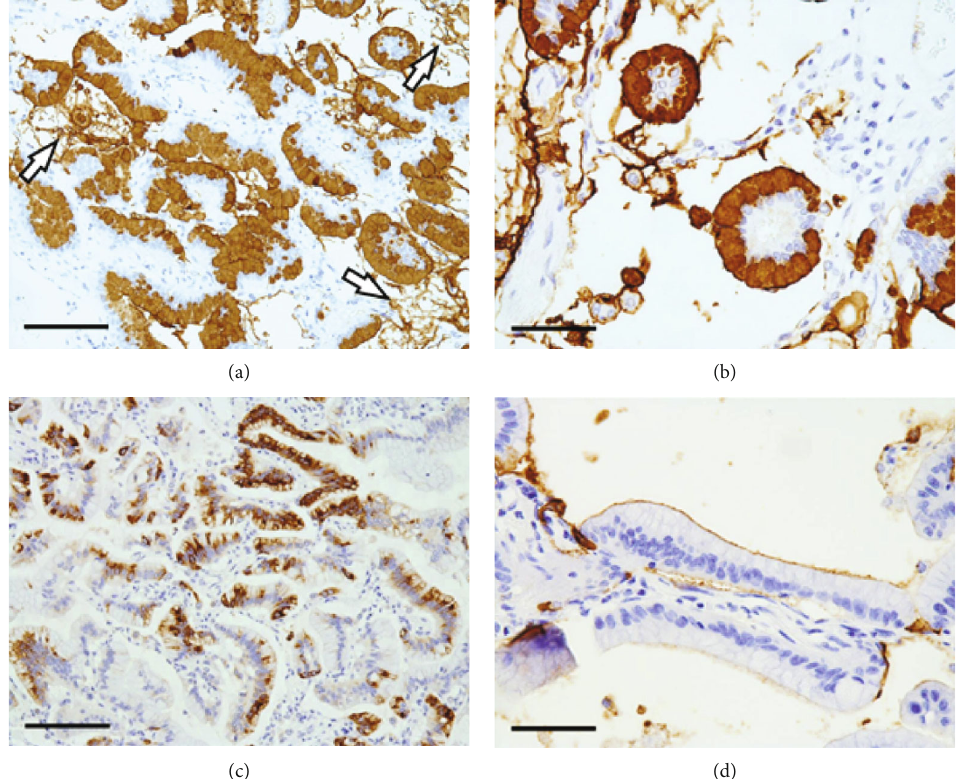
Figure 4: Immunostaining of mucin glycoproteins in the left lung tumor. (a) Di ff use cytoplasmic positivity is visible in the lepidic or papillary component, and positive staining is present in the alveolar spaces (arrows). MUC 5AC immunostain, scale bar: 200 μ m. (b) Floating tumor cells exhibit the same positive reaction. MUC 5AC immunostain, scale bar: 100 μ m. (c) Some tumor cells exhibit cytoplasmic positivity.